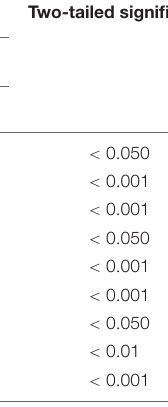
TABLE 6 | Direct and mediation effects. Paths Point